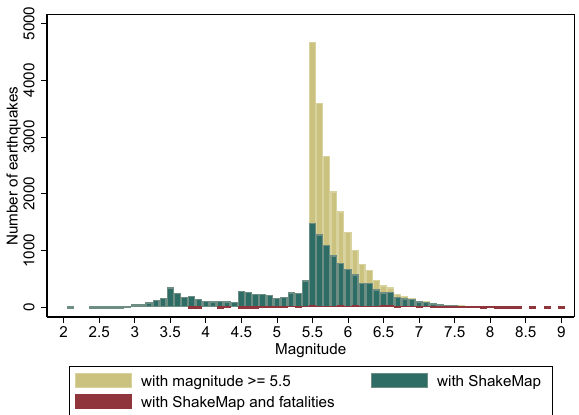
Figure C4. The distribution of magnitude for events from January 1973 to October 2016. ShakeMaps are systematically produced for all events with magnitude 5.5 or greater and the share of events with ShakeMap increases with